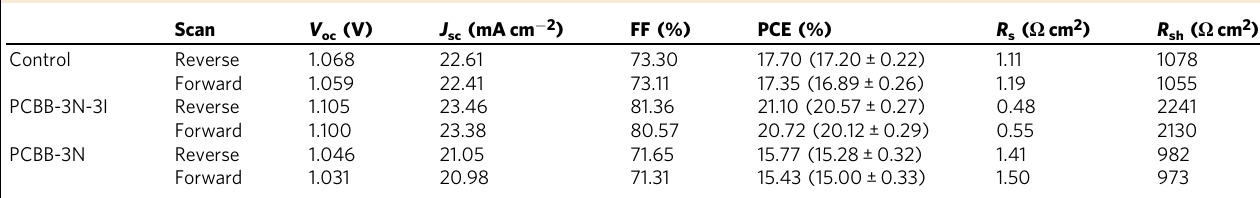
Table 1 Photovoltaic parameters of